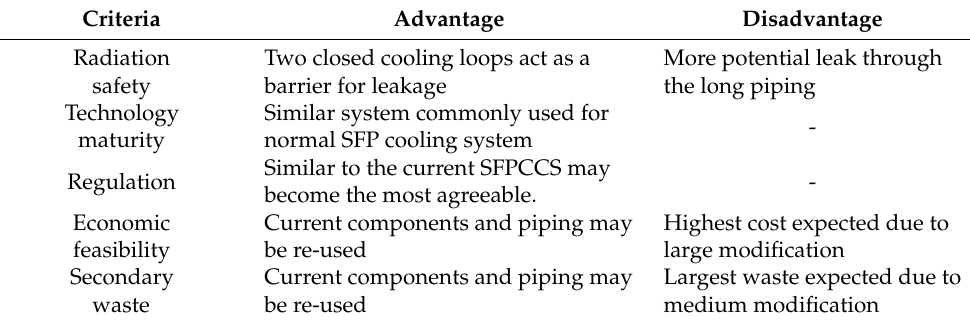
Table 13. Evaluation summary of ocean-cooled indirect heat exchange